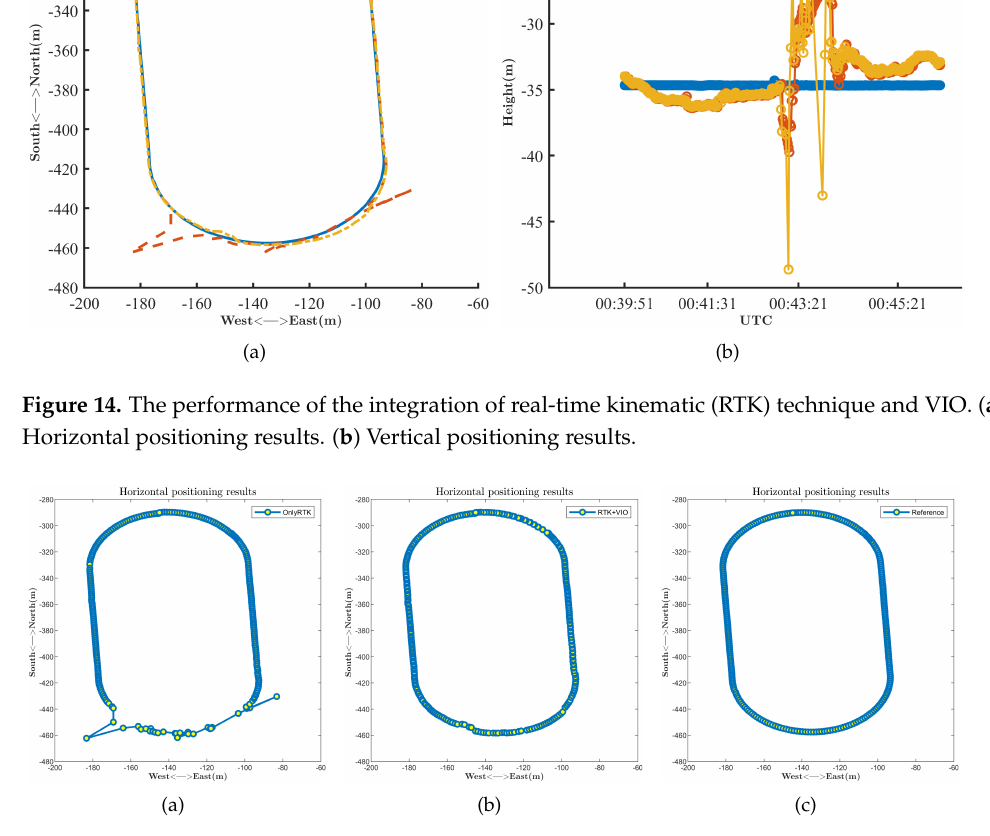
Figure 15. The performance comparison of RTK, RTK/VIO, and the reference. ( a ) Valid positioning results of RTK. ( b ) Valid positioning results of RTK/VIO. ( c ) The reference.